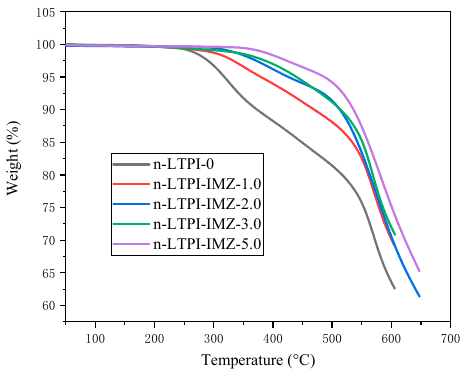
◦ C/2 h cured n-LTPI films with different IMZ Figure 9. TGA of the 230 °C/2 h cured n-LTPI films with different IMZ loadings. Figure 9. TGA of the 230